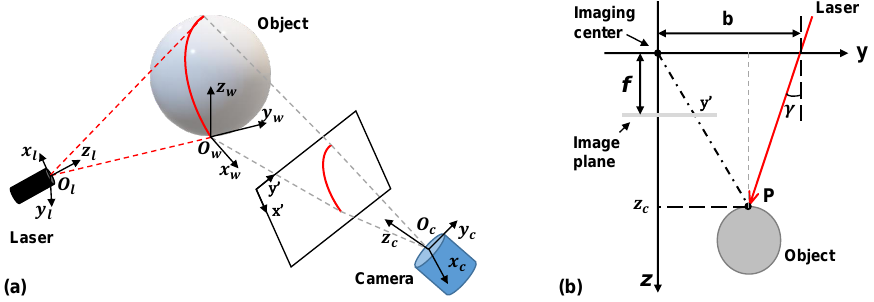
Figure 2. ( a ) Principle of the laser light section method. The laser beam falls on the object and is observed by the camera. ( b ) 3D coordinates of the laser light projected on the object surface can be reconstructed by the triangular principle. γ is the deviation angle with respect to the optical axis of the camera and b is the axial distance between the camera and the laser light